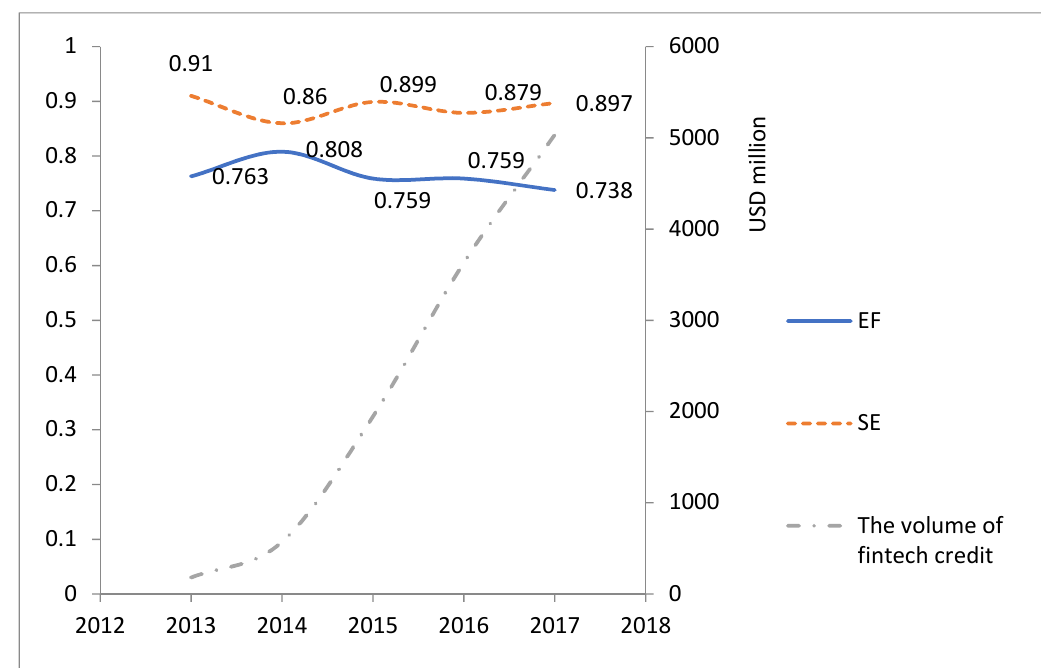
Figure 1. The evolution of banking efficiency ( left axis) and the volume of fintech credit ( right axis).